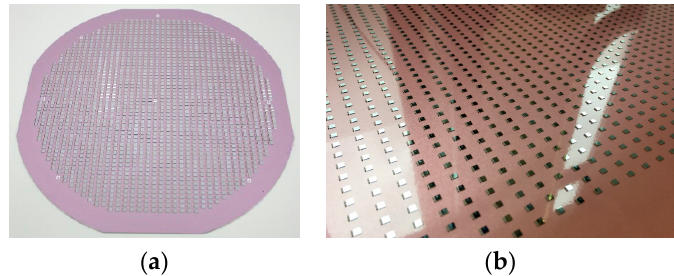
Figure 5. Die and SMD assembly on the carrier; ( a ) 200 mm wafer, ( b ) detail of the 457 × 305 mm² panel.